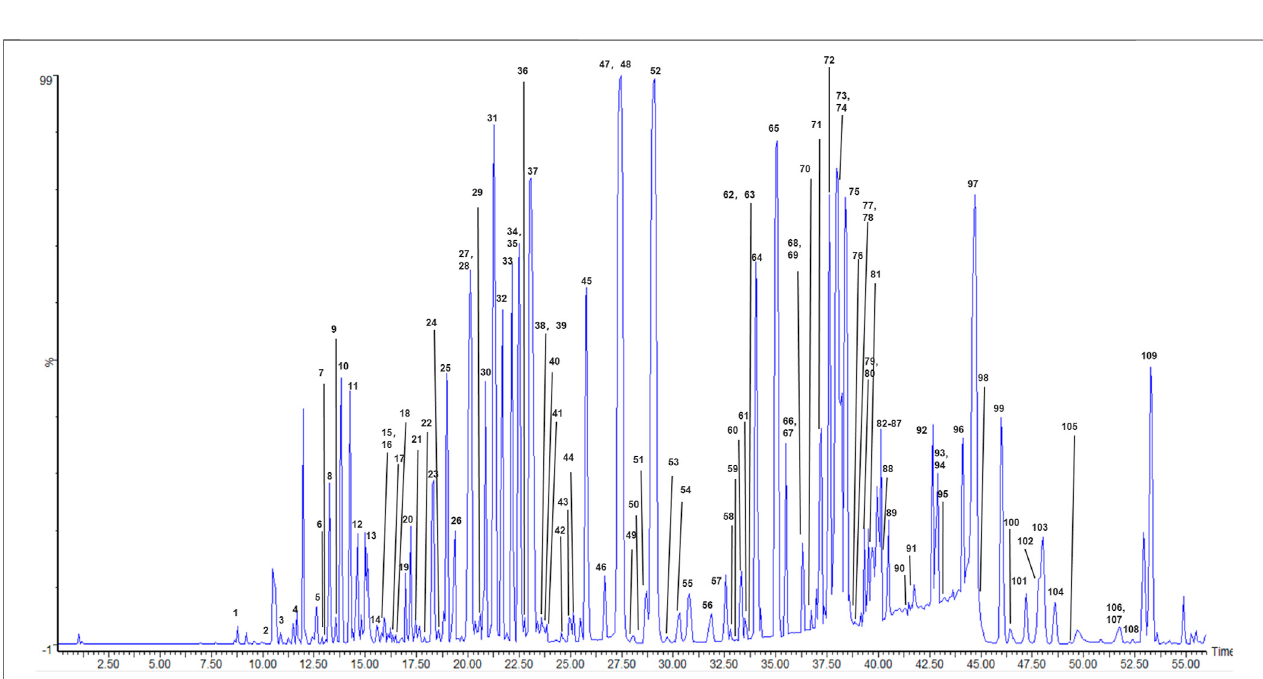
FIGURE 10 | Base peak ion chromatogram of Bupleurum marginatum var. stenophyllum (BMS).